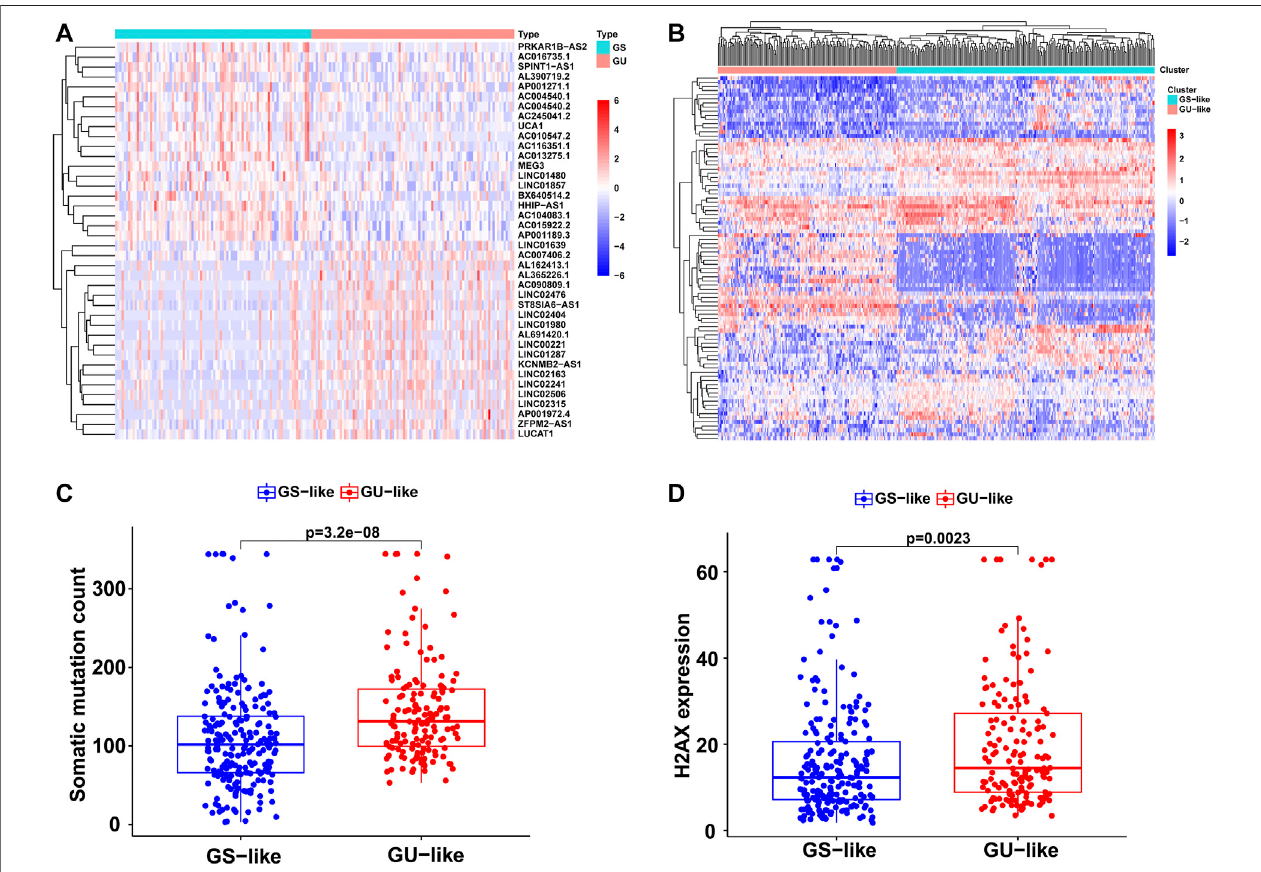
FIGURE1| Identi fi cationoftheGI-relatedlncRNAsinHCC. (A) Thetop20mostdifferentiallyexpressedlncRNAsbetweentheGSandGUgroup. (B) Unsupervised clustering of 374 HCC samples based on the 88 GI-related lncRNAs. The red cluster is the GU-like group and the blue cluster is the GS-like group. (C) Boxplots of somatic mutations between the GU-like group and GS-like group. (D) Boxplots of H2AX expression level between the GU-like group and GS-like